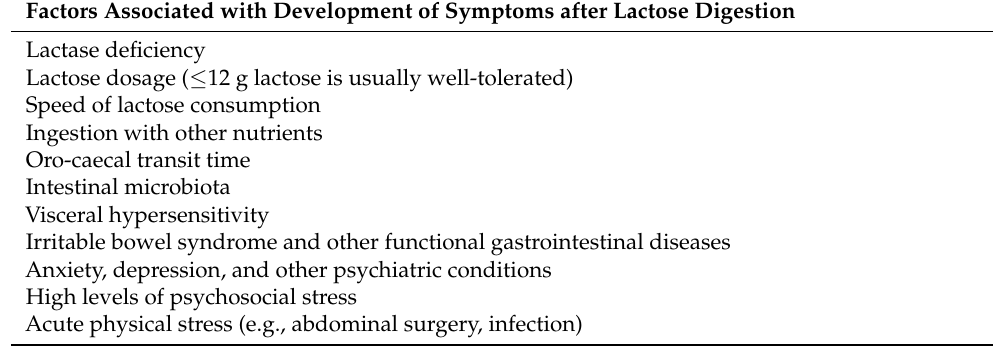
Table 3. Factors associated with the development of symptoms after lactose digestion, based on [17]. Factors Associated with Development of Symptoms after Lactose Digestion Lactase deficiency Lactose dosage ( ≤ 12 g lactose is usually